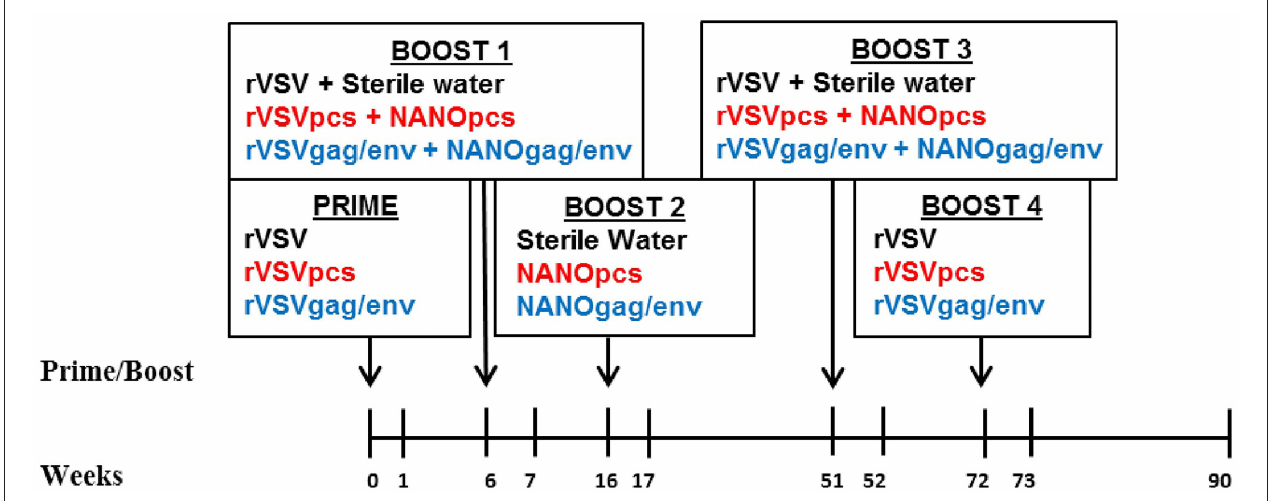
FIGURE 1 | Immunization and sampling scheme. Prime and boosts were given to three groups of 8 female MCMs on the indicated weeks. CVL samples were collected on all time points. Control group received rVSV vector and/or sterile water (black font), PCS group received rVSVpcs and/or NANOpcs (red font), Gag/Env group received rVSVgag/env and/or NANOgag/env (blue font). rVSV, rVSVpcs, and rVSVgag/env were administered intramuscularly. NANOpcs and NANOgag/env boosts were administered